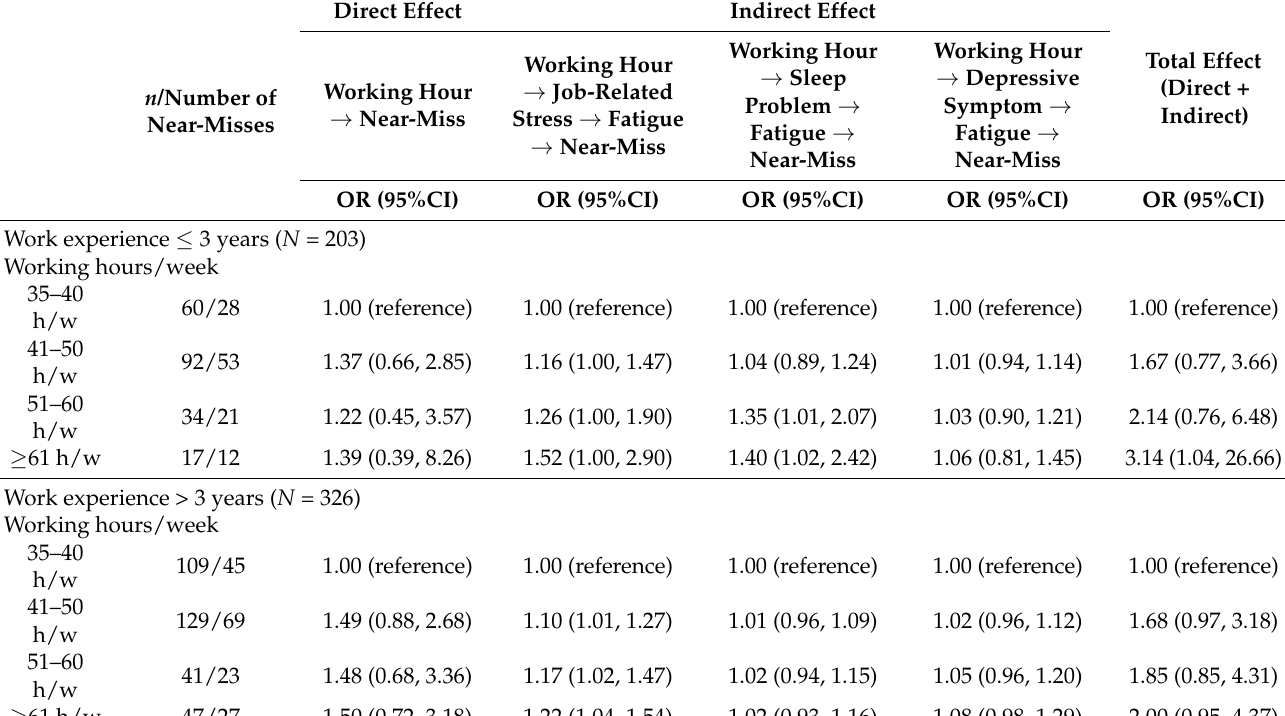
Table 4. Direct, indirect, and total effects of working hours on near-misses during the past six months by work experience subgroup among healthcare professionals aged under 35